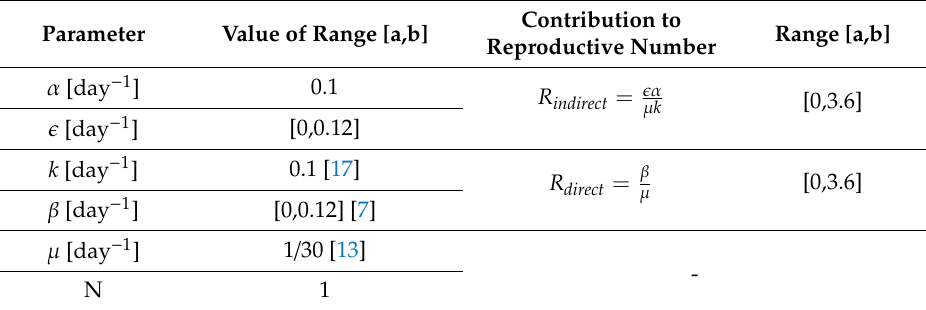
Table 1. Epidemiological parameters were chosen to explore a range of reproductive number with equivalent contribution possible from direct and / or indirect transmission. The epidemiological parameters are known to vary with strain [9], but the range of values listed in the table are based on typical values from the literature [6–8,13,17].